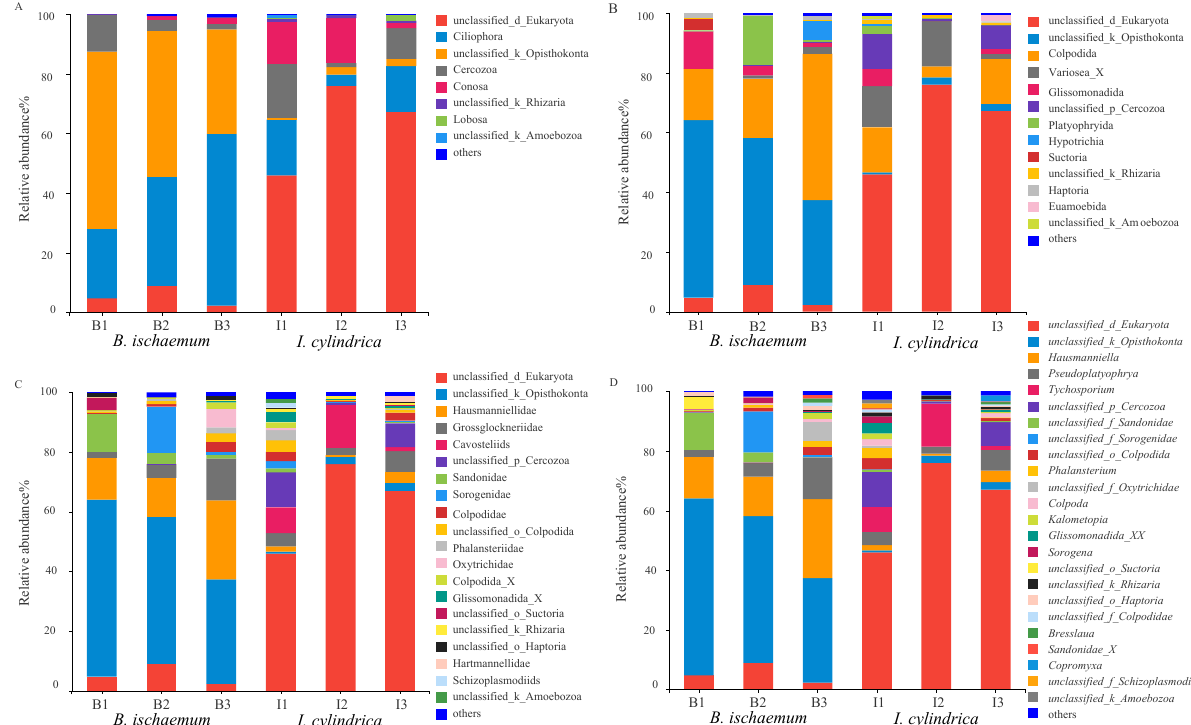
Figure 1. Composition of protist communities in litters at different taxonomic levels. ( A ): Phylum. ( B ): Order. ( C ): Family. ( D ): Genus level. B1, B2 and B3 represent litter samples of B. ischaemum. I1, I2 and I3 represent litter samples of I. cylindrica